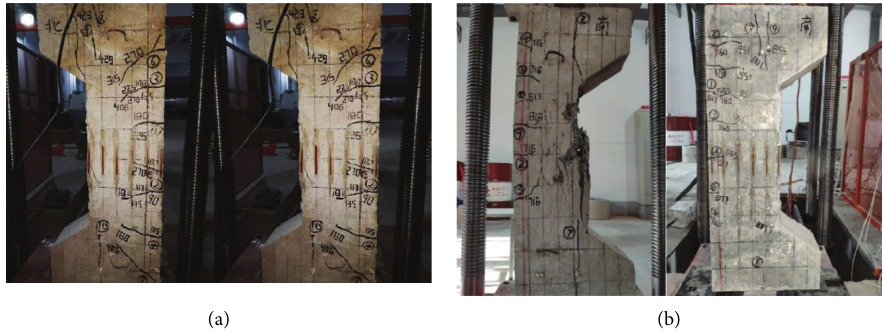
Figure 6: Failure mode of the specimen. (a) Large eccentric compression failure. (b) Small eccentric compression